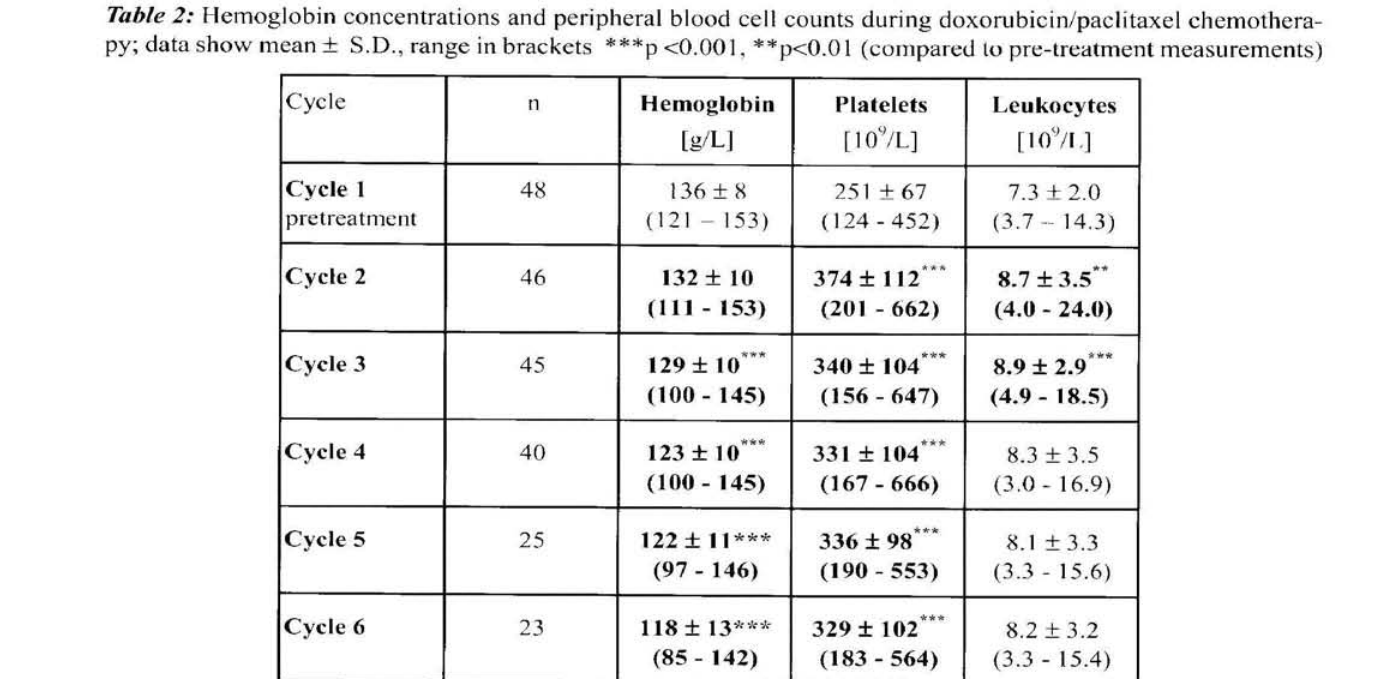
Table 2: Hemoglobin concentrations and peripheral blood cell counts during doxorubicin/paclitaxel chemothera-